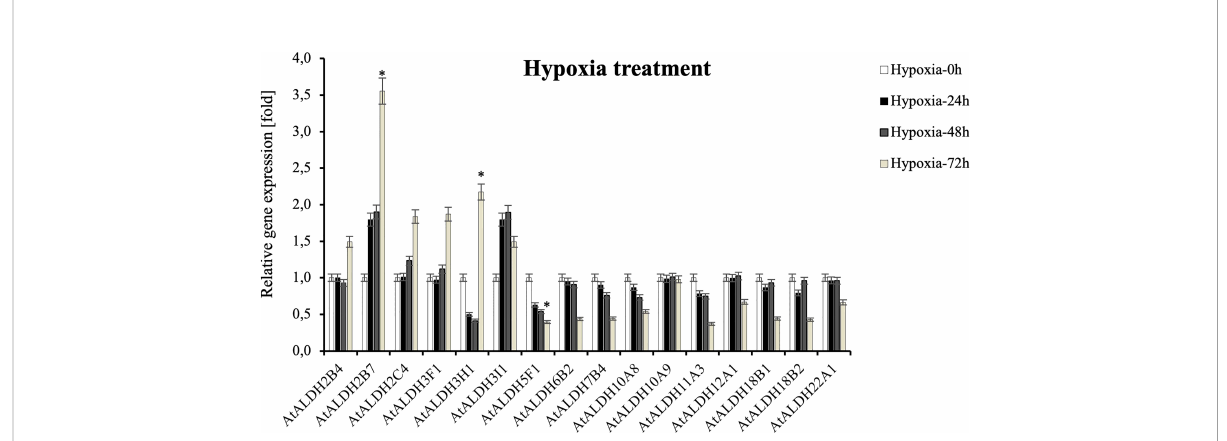
FIGURE 10 Relative gene expression of AtALDHs under hypoxia. Analyses were performed in Arabidopsis leaves of plants exposed to stress at selected time points: 0h (control), 24h, 48h, and 72h. All values represent the means of data ± SD of at least three independent experiments ( n =9). Asterisks (*) indicate values that differ signi fi cantly after hypoxia treatment as compared to 0h (control) at a <0.05. The analysis of variance was conducted and the least signi fi cant differences (LSDs) between means were determined using Tukey ’ s test at the level of signi fi cance a